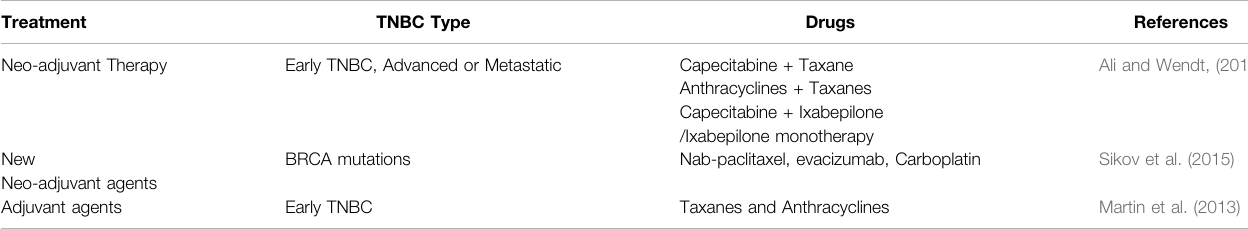
TABLE 1 | Conventional treatment option for